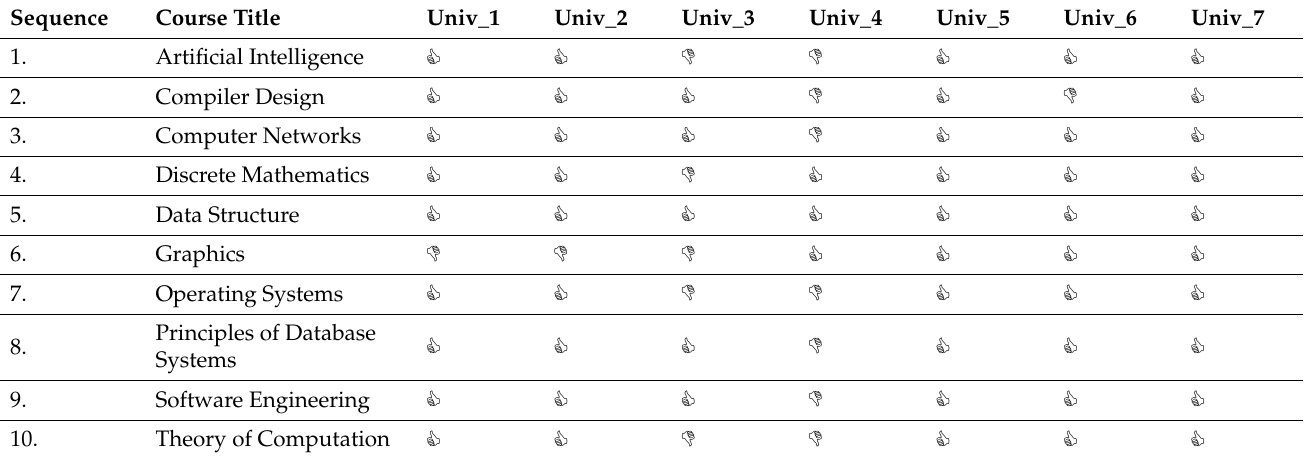
Table 2. List of computer science courses that have been included in the syllabus at top universities.